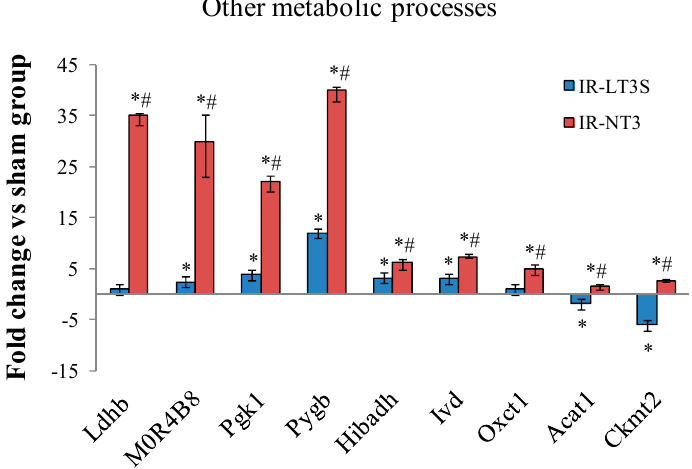
Figure 5. Differentially expressed proteins involved fatty acid metabolism. Data are expressed as median and interquartile range. * p vs. sham < 0.017; # p vs. IR-LT3S < 0.017. Protein acronyms are listed in the abbreviation list.